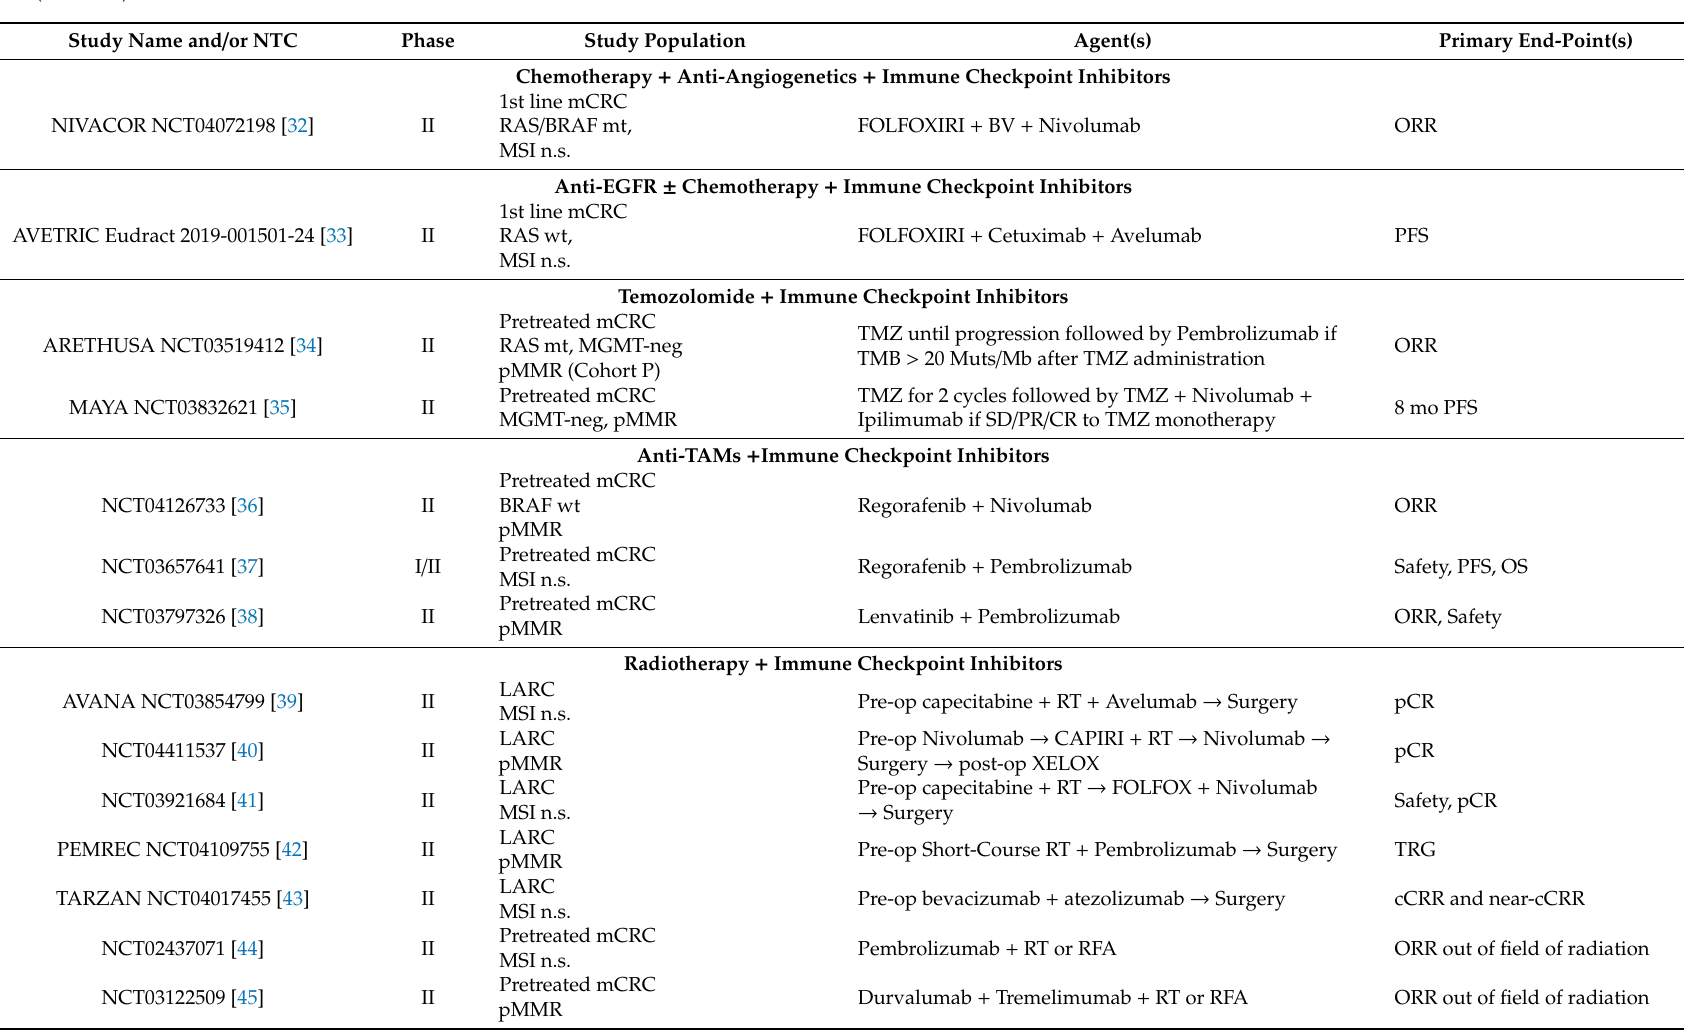
Table 2. Selection of ongoing trials investigating the use of immune checkpoint inhibitors for proficient mismatch repair (pMMR) or non-specified microsatellite status (MSI n.s.) colorectal